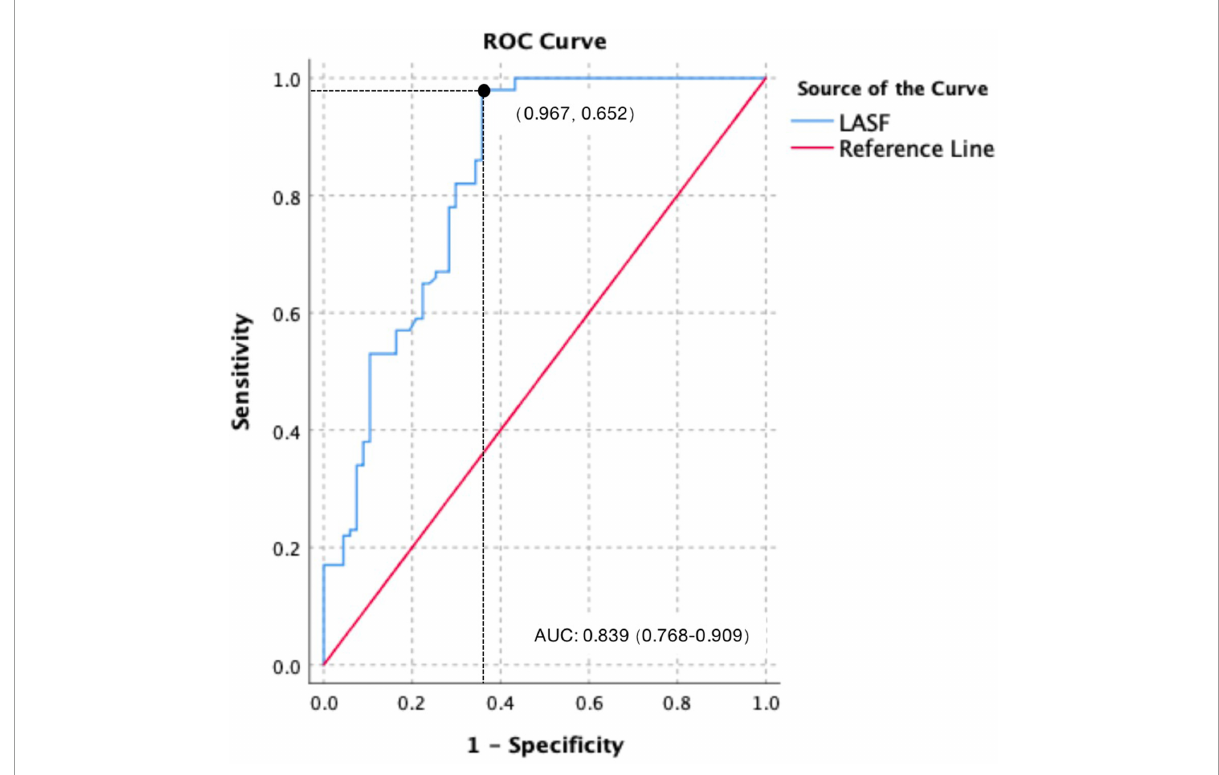
FIGURE3 Receiver operating characteristic (ROC) curve of LASF to predict GDM fetal septal